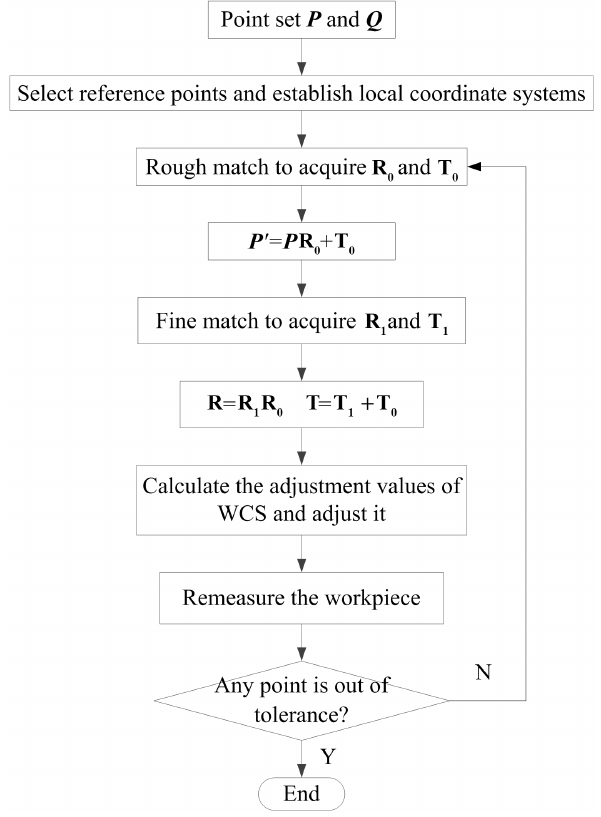
Figure 1. The procedure of stepwise matching